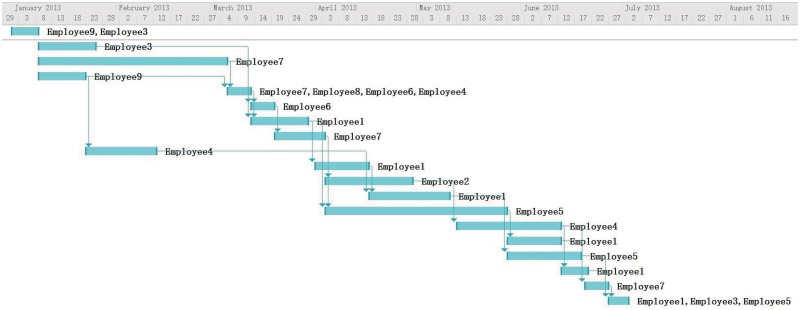
Scheduling Result from Expert 1.